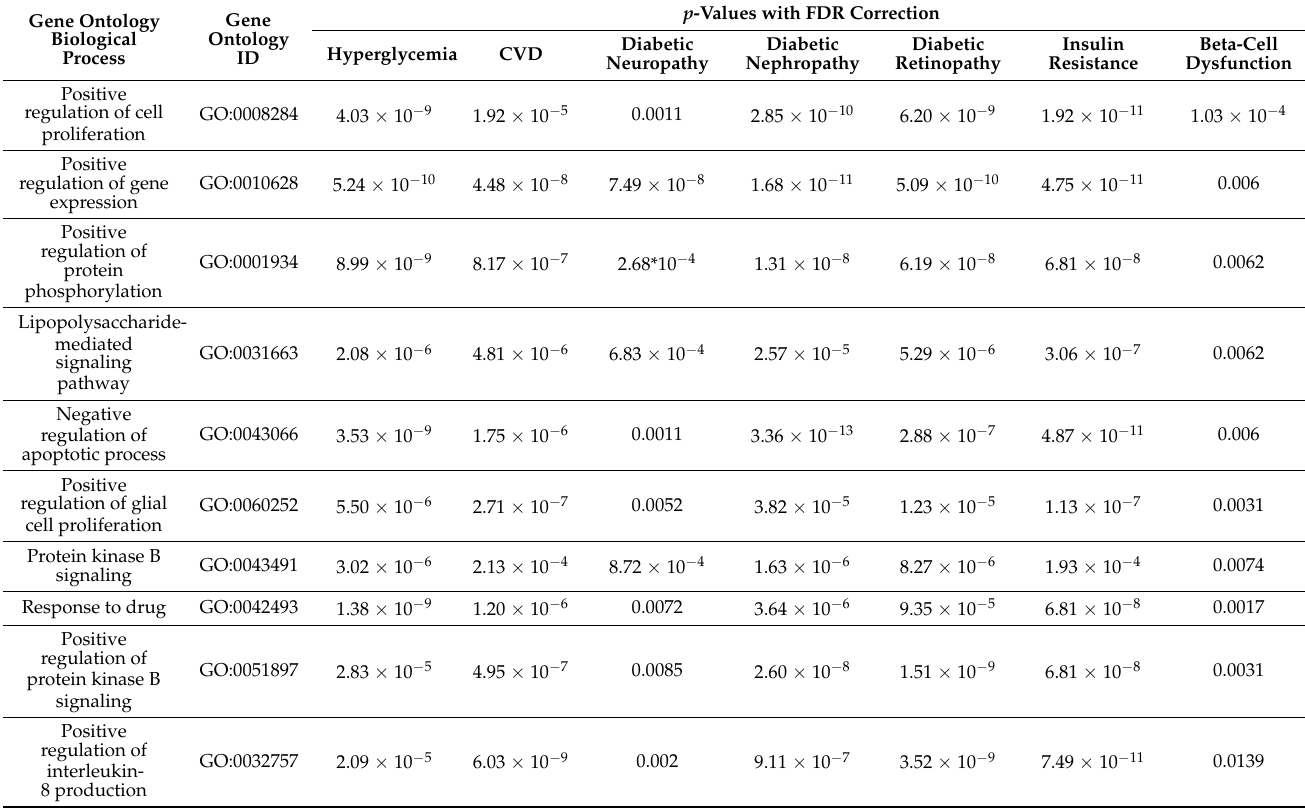
Table 7. Most overrepresented GO biological processes that are common for the sets of genes linked with CTSB and associated with hyperglycemia, CVD, diabetic neuropathy, diabetic nephropathy, diabetic retinopathy, insulin resistance, and beta-cell